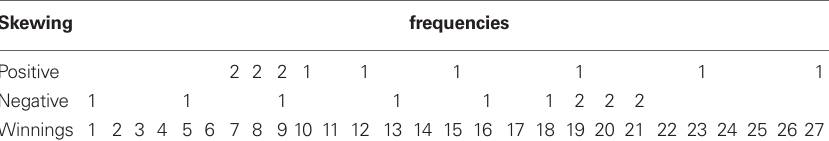
Table 1 | Frequency distribution of winnings. Skewing